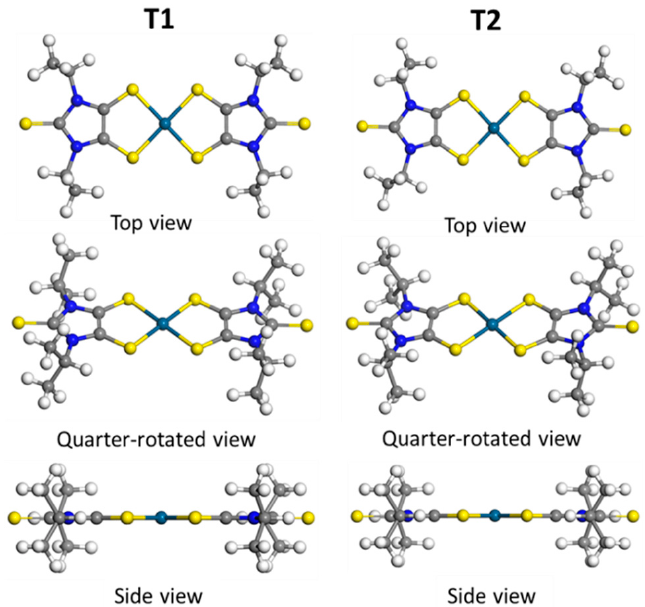
Figure 2. Top, side, and quarter-rotated views of T1 and T2 structures after optimization, showing the chemical geometry.